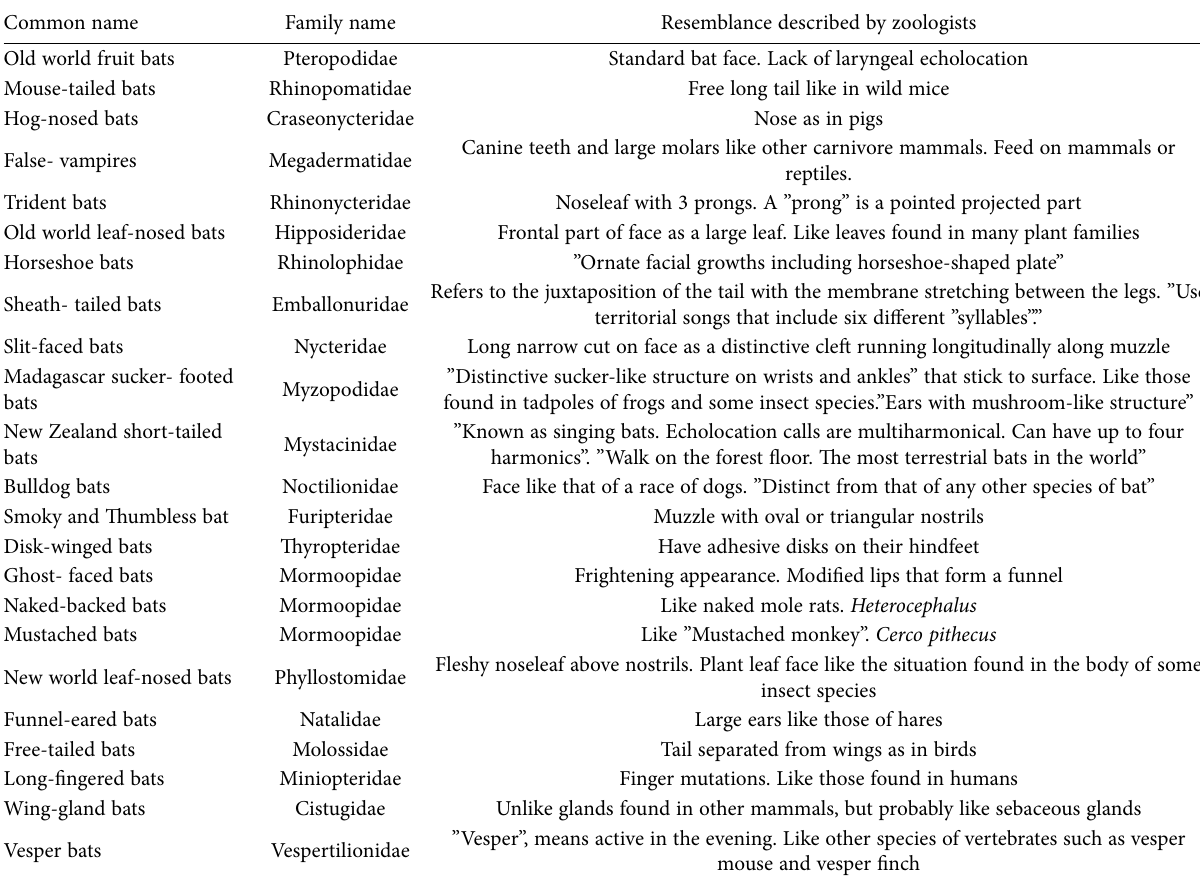
Table 2. Bat families and their resemblance to plant and animal structures and functions. Common and scientific names according to Wil- son and Mittermeier (2019), “Handbook of the mammals of the world” Vol. 9. The words used and the statements made by the authors are in quotation